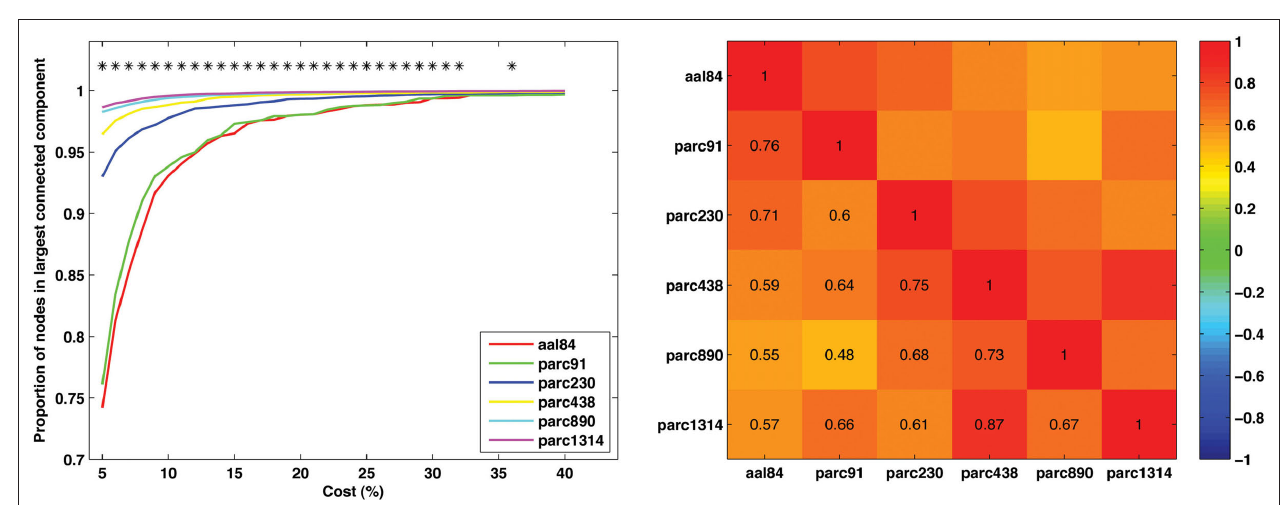
FIguRe 4 | Mean values and individual differences in network connectedness as a function of parcellation scale. Left: Sample mean size of largest connected network component for each parcellation scale across all costs examined (* p < 0.05). Right: correlation matrix of inter-scale associations for the cost at which each individual’s network became